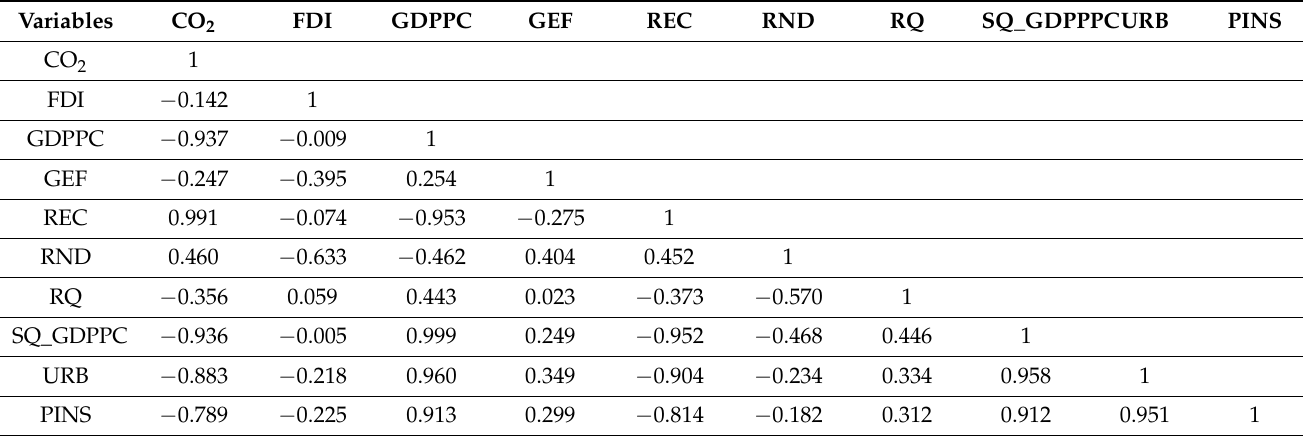
Table 3. Correlation